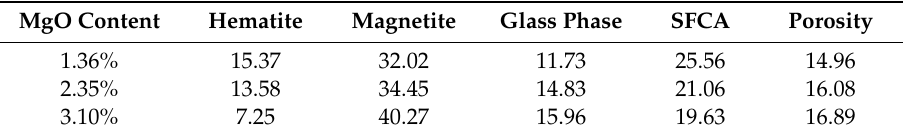
Table 1. Mineral compositions of sinter with various MgO contents / area, %. MgO Content Hematite Magnetite Glass Phase SFCA